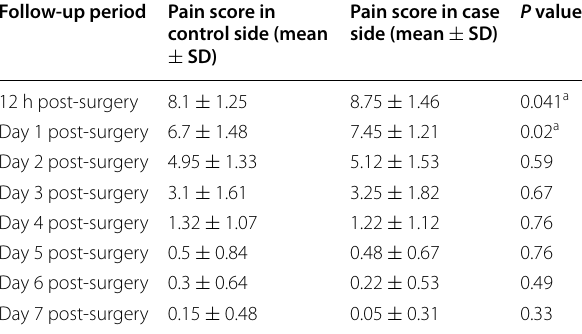
SD standard deviation a Statistically significant